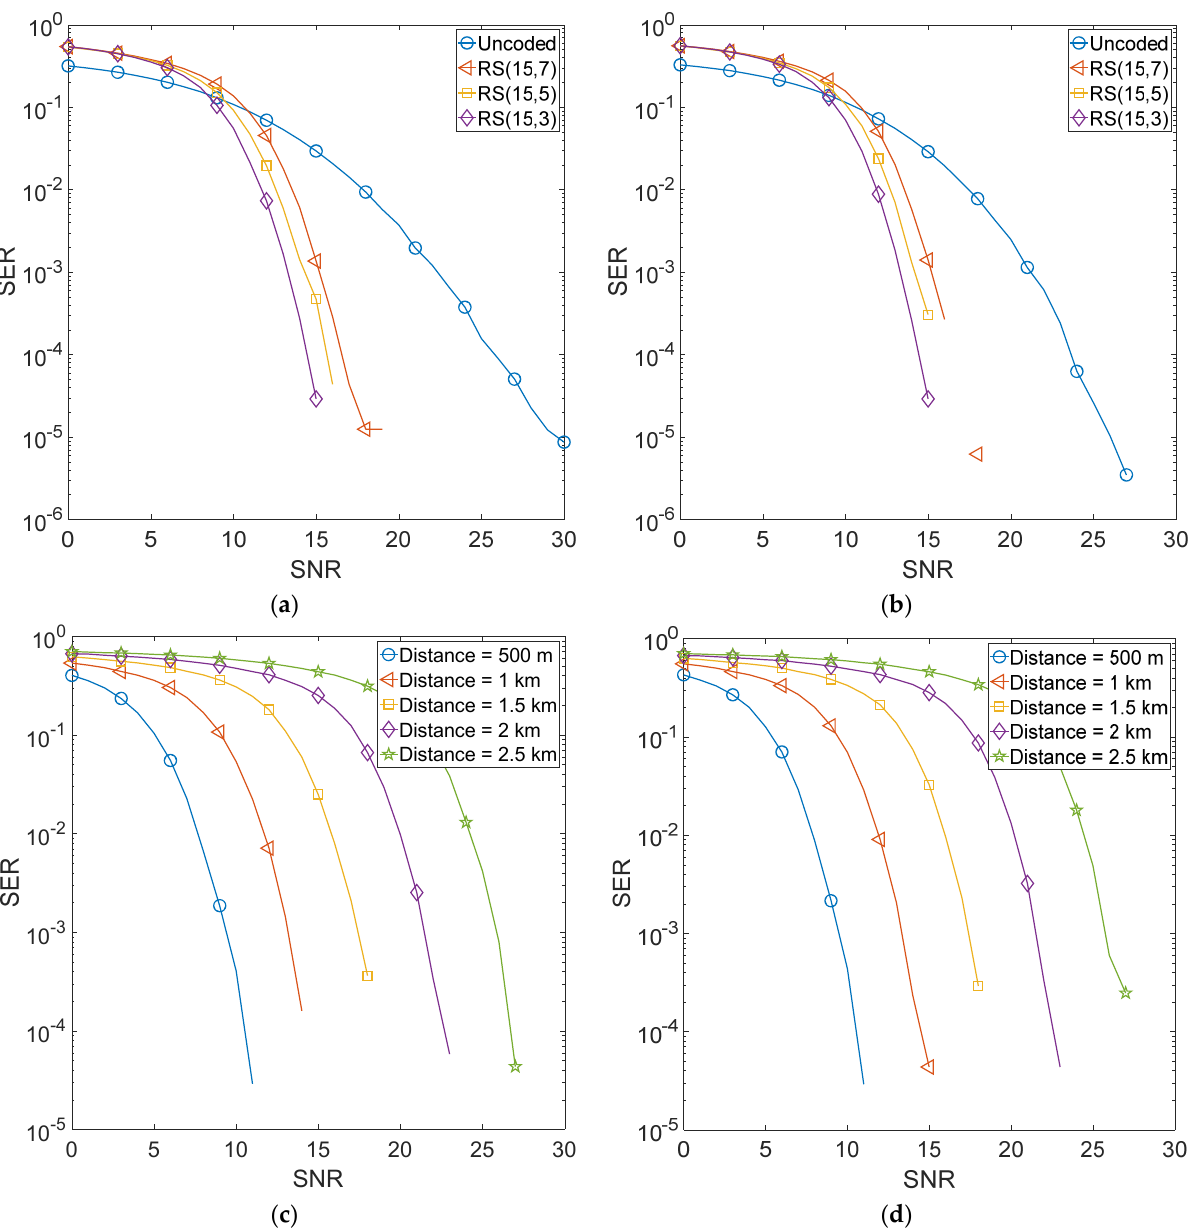
Figure 4. RS encoded 4QAM-GFDM schemes. ( a ) Comparison of selected RS schemes with MF equalizer. ( b ) Comparison of selected RS schemes with ZF equalizer. ( c ) Error performance as a function of Tx-Rx distance for RS (15,3) scheme with MF equalizer. ( d ) Error performance as a function of Tx-Rx distance for RS (15,3) scheme with ZF equalizer.